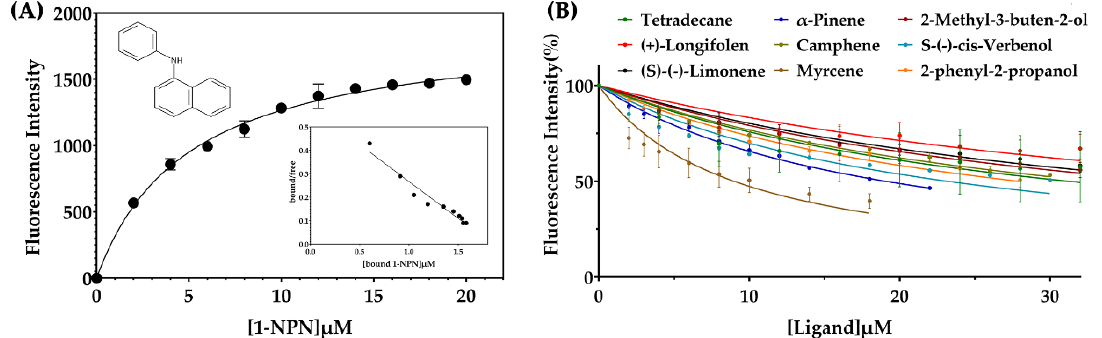
Figure 6. Competitive fluorescence ligand-binding assay of EparOBP2 to ligands. ( A ): Binding curve and relative Scatchard plot of EparOBP2 and 1-NPN. ( B ): Competitive binding curves of EparOBP2 with nine ligands. Table 1. Binding affinities of different ligands to EparOBP2.